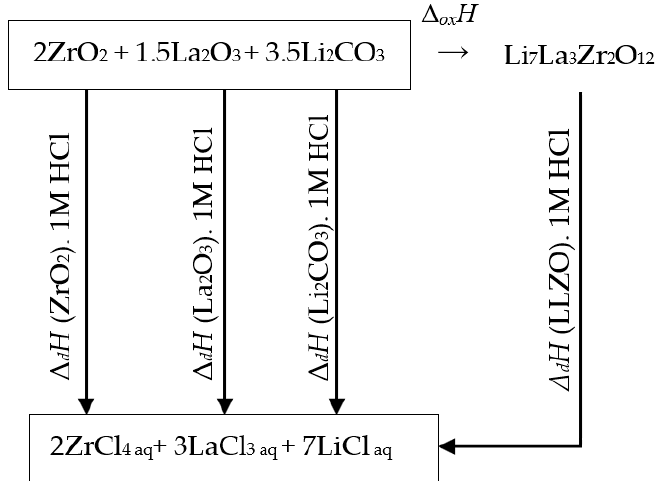
Figure 4. Diagram of the thermochemical dissolution cycle of Li 7 La 3 Zr 2 O 12 in HCl. Table 2. The dissolution enthalpies values of the initial components and the Li 7 La 3 Zr 2 O 12 compound